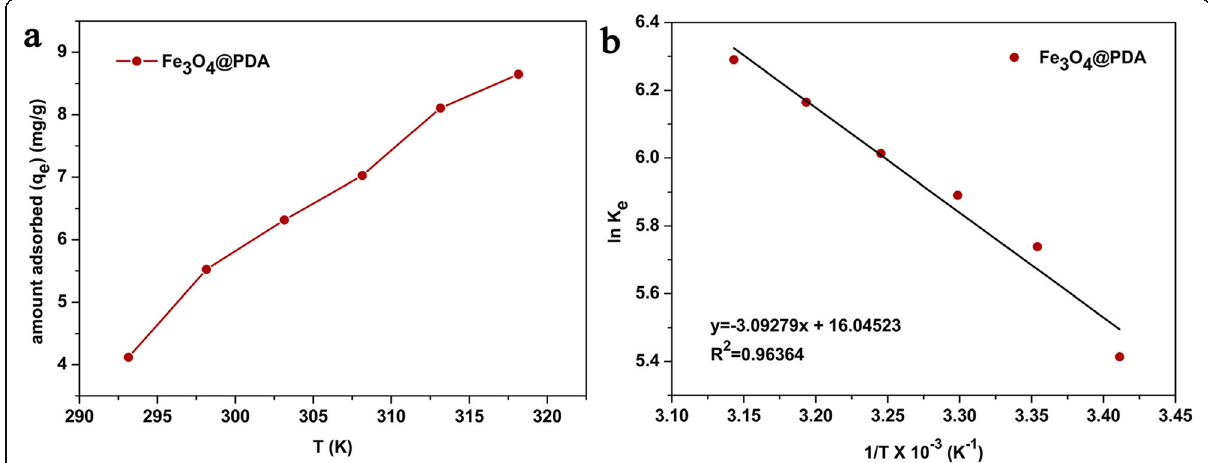
Fig. 6 a Effect of temperature on the adsorption of Cd 2+ and b relationship between ln K e and 1/ T for the Cd 2+ adsorption on Fe 3 O 4